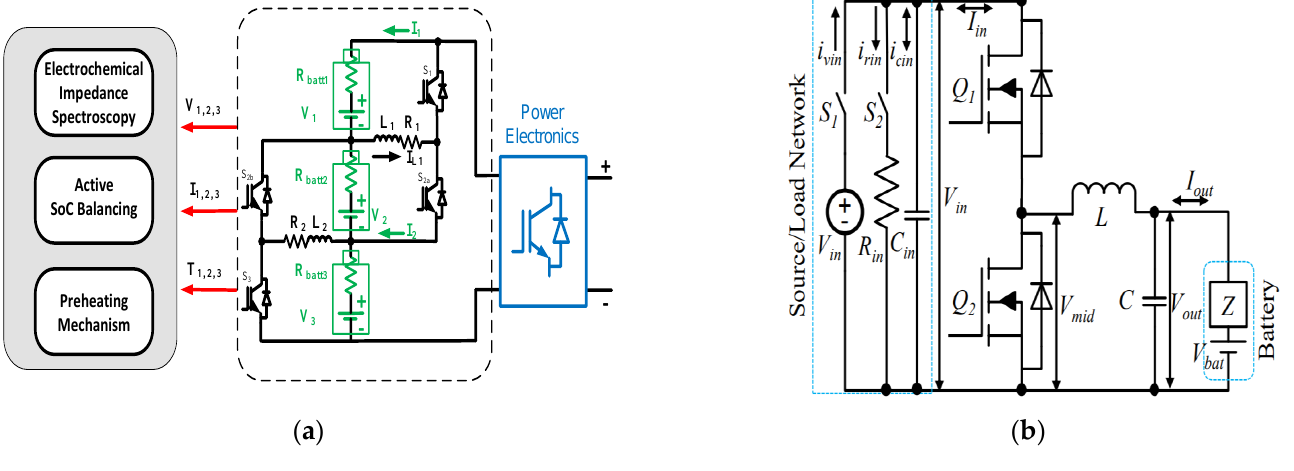
Figure 1. Embedded EIS into: ( a ) BMS [21]; ( b ) battery charger